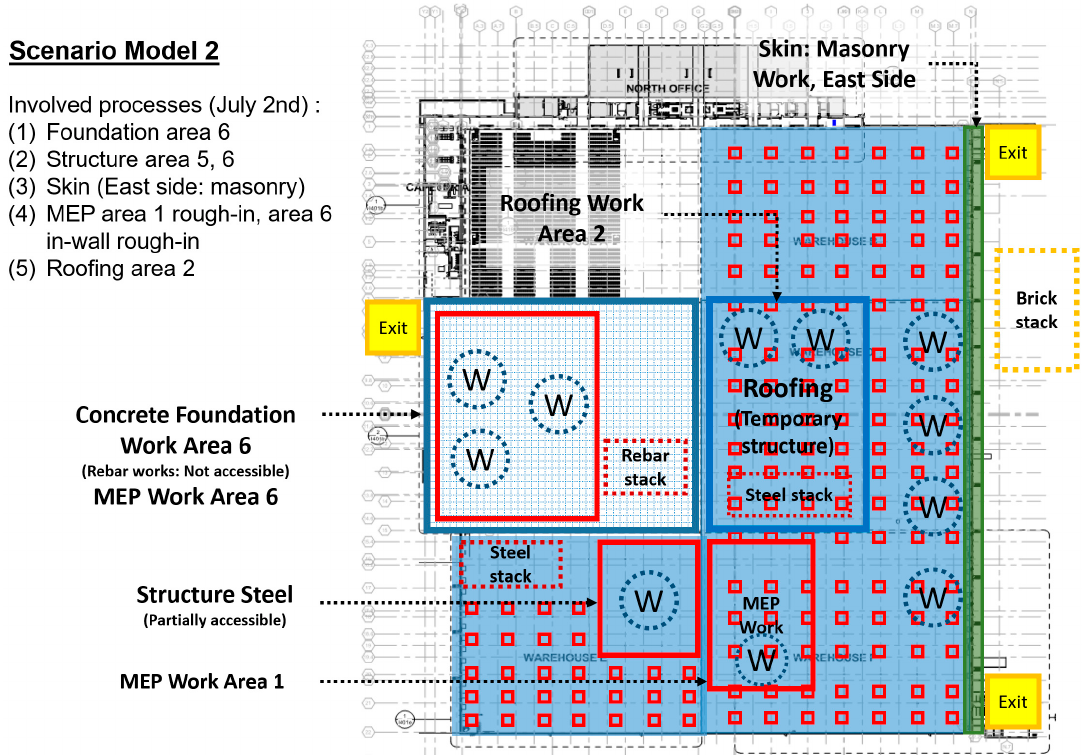
Figure 7. Scenario Model 2: Work status and site conditions. Appl. Sci. 2019 , 9 , x FOR PEER REVIEW